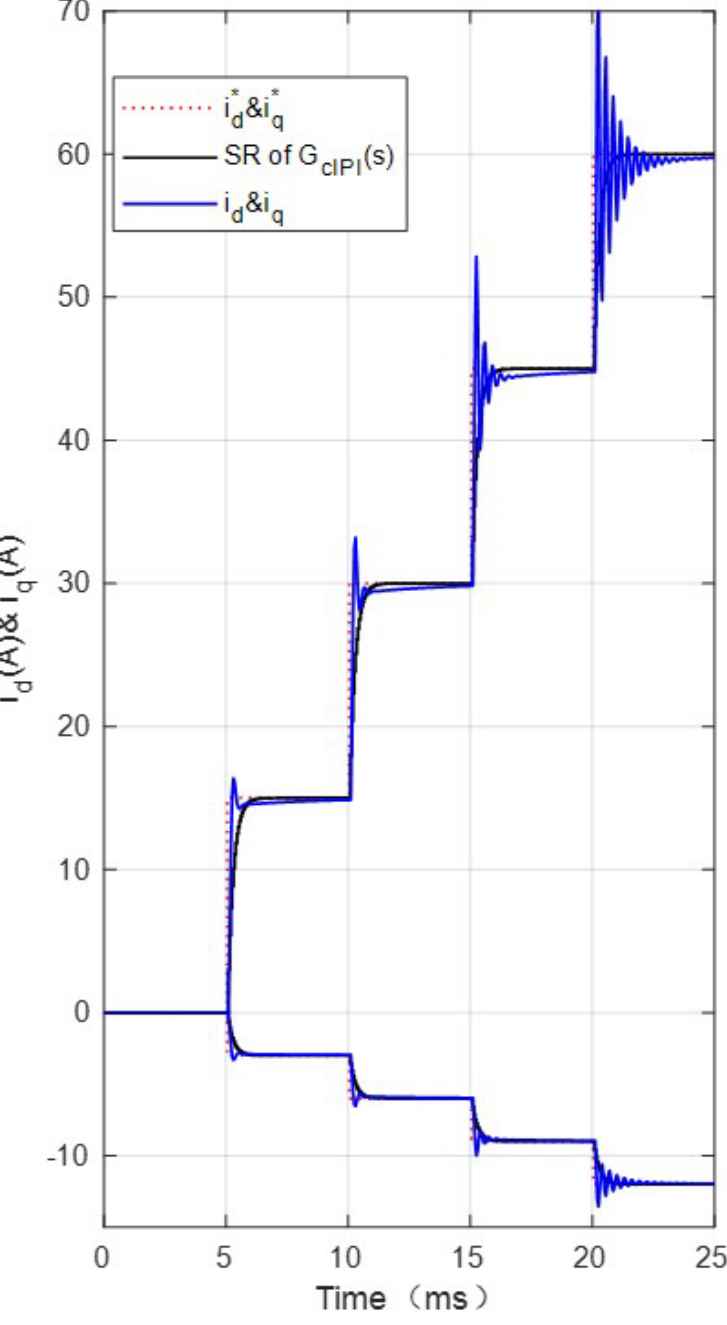
Figure 8. Simulation result of PI controller based on DIMC ( α = 4000 rad/s) of the locked saturated machine.